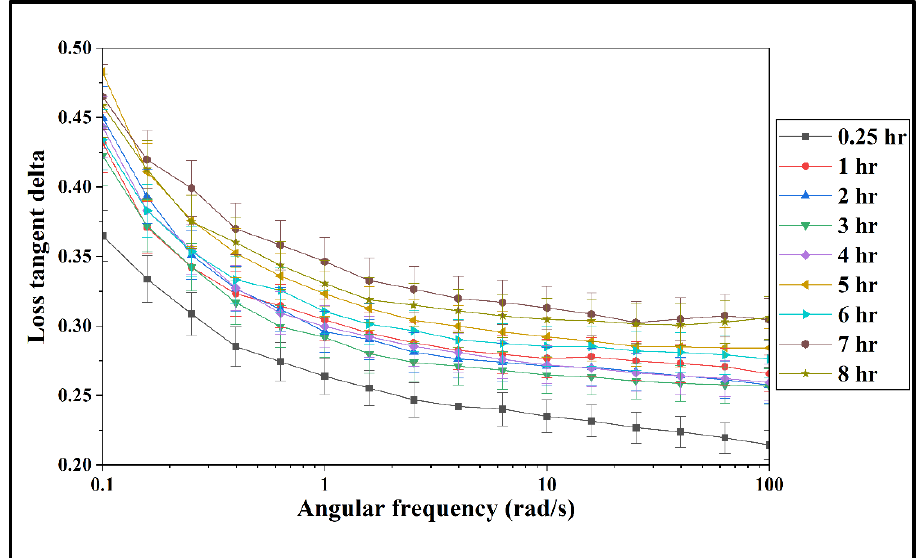
Figure 13. Loss tangent delta vs. angular frequency graphs at 9 different levels of waiting time.